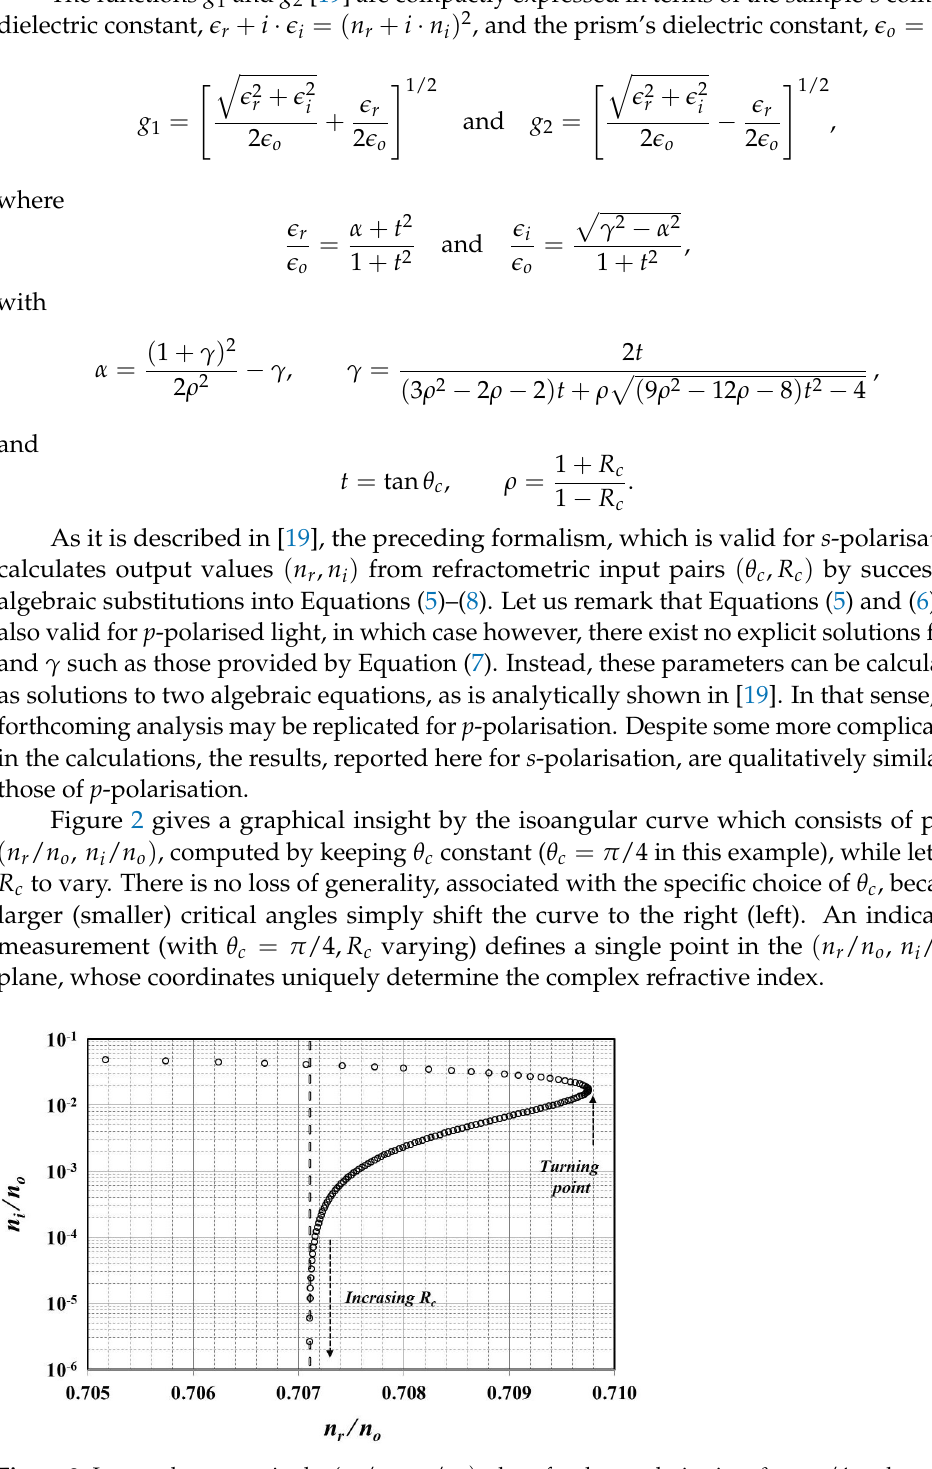
Figure 2. Isoangular curves in the ( n r / n o , n i / n o ) -plane for the s -polarisation, θ c = π /4 and variable R c . As one moves along the direction of the arrow, R c increases in steps of 0.005, within the range [ 0.385,0.990 ] . The vertical dashed line marks the transparency limit, n r / n o = sin ( π /4 )